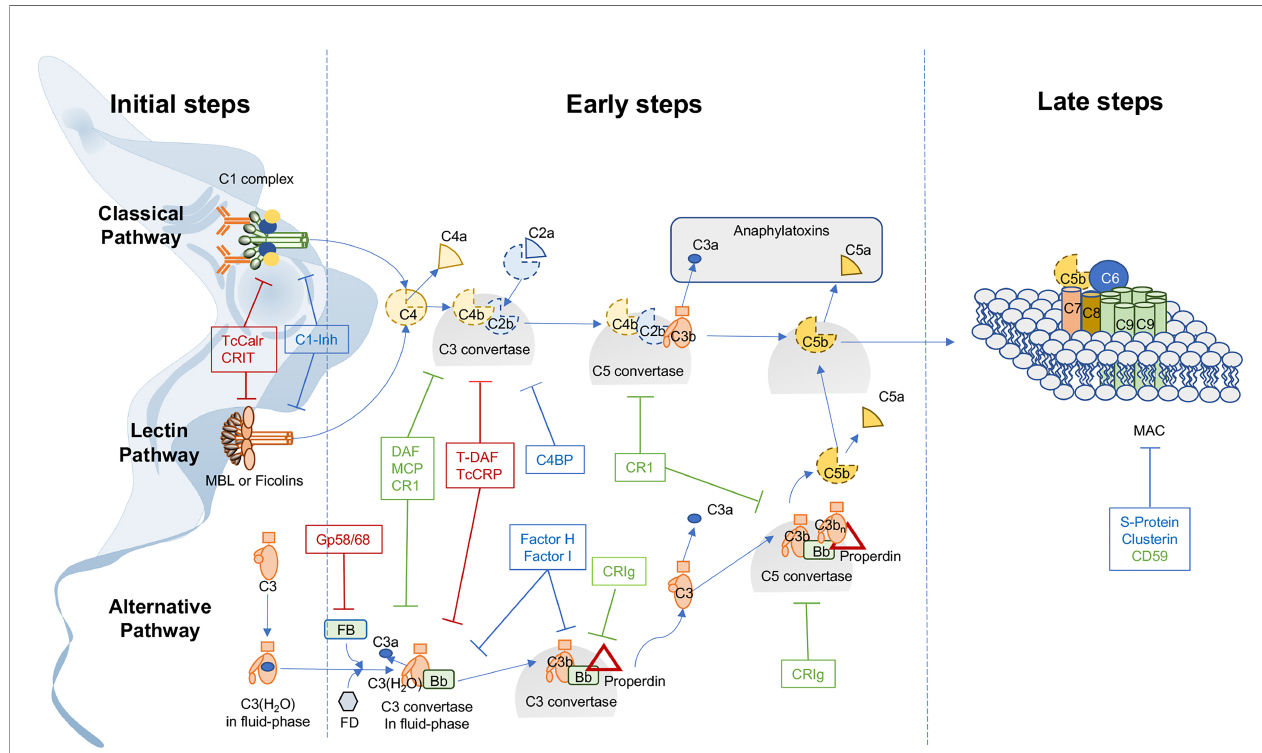
FIGURE 1 | Trypanosoma cruzi expresses, secretes, or recruits complement regulatory proteins and intervening in the interaction of these T. cruzi -derived regulatory proteins with complement can affect host-parasite interactions. The complement system (C) is activated by three different pathways: classical (CP), lectin (LP) and alternative (AP). (1) In the initiation steps, these pathways are activated by the identi fi cation of different pathogen-associated molecular patterns (PAMPs) present on microorganisms such as T. cruzi . Thus, the CP is activated when C1 complex (C1qr 2 s 2 ) recognizes antibodies bound to T. cruzi or acute phase proteins. The LP is activated when MBL and fi colins form complexes with serine proteases (MASPs) in the presence of carbohydrates. The AP is activated by spontaneous hydrolysis of C3, near a variety of non-self cell surfaces. (2) In the early steps, all activated pathways converge in the generation of C3 convertases, that continuously cleave C3 into C3a and C3b continuing with the enzymatic cascade that also generates C5 convertases that produce the split products C5a and C5b. (3) Finally, in the late step, C5b anchored to the pathogen surfaces, in conjunction with C6-C9, form the membrane attack complex (MAC) and lyse the pathogen. Thus, C activation induces opsonization (by C3b and C4b), in fl ammation (by C3a and C5a) and lysis of microorganisms such as T. cruzi . However, C activation is stringently controlled by C regulatory proteins. The membrane bound regulatory proteins are: Decay-accelerating factor (DAF), membrane co-factor protein (MCP), C receptor 1 (CR-1) CD59 and complement receptor of immunoglobulin family (CRIg) (in green). Regulatory proteins found in plasma are: Factor I, Factor H, C4 binding protein (C4BP), C1-inhibitor (C1-Inh), S-protein and Clusterin (in blue). These proteins limit ampli fi cation of the downstream cascade. To evade C activation, Trypanosoma cruzi expresses and secretes complement regulatory proteins with homologous function with their human counterparts (in red). Thus, CRIT and TcCalr inhibit C in early stages of activation, and T-DAF, TcCRP and gp58/68 participate in intermediate stages of